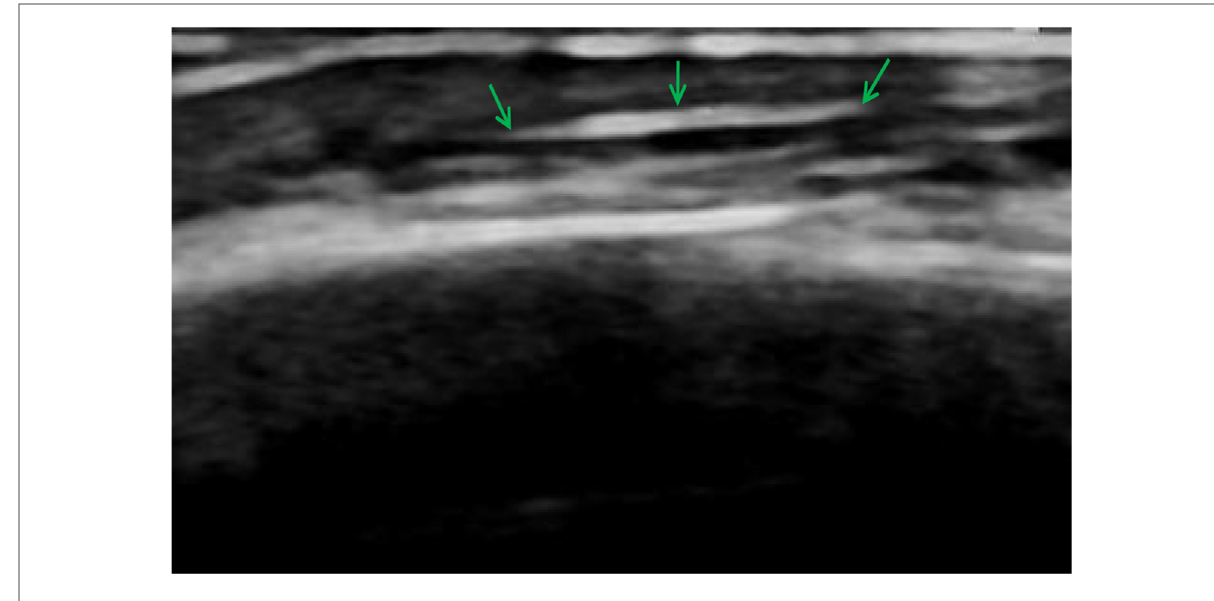
FIGURE 1 B-ultrasound con fi rmed that the subcutaneous indwelling needle showed a thin strip of echo under the scalp.